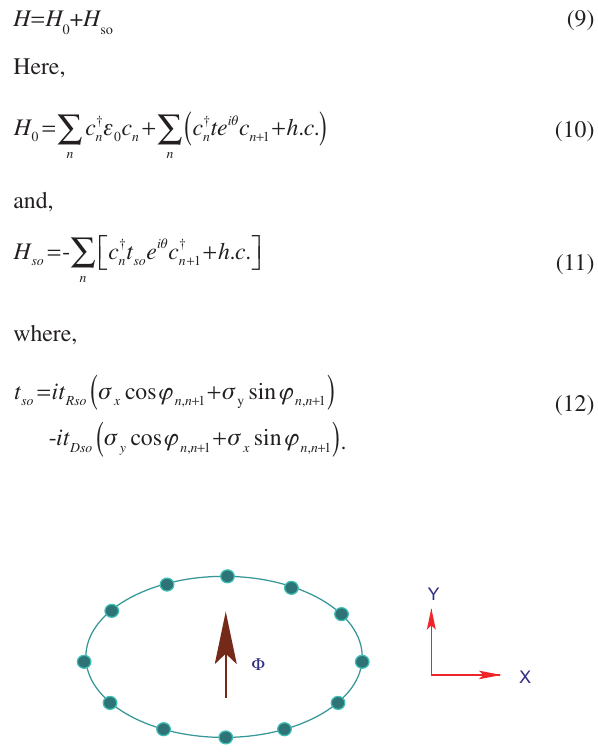
Figure 17 A mesoscopic ring threaded by an AB fl ux φ .